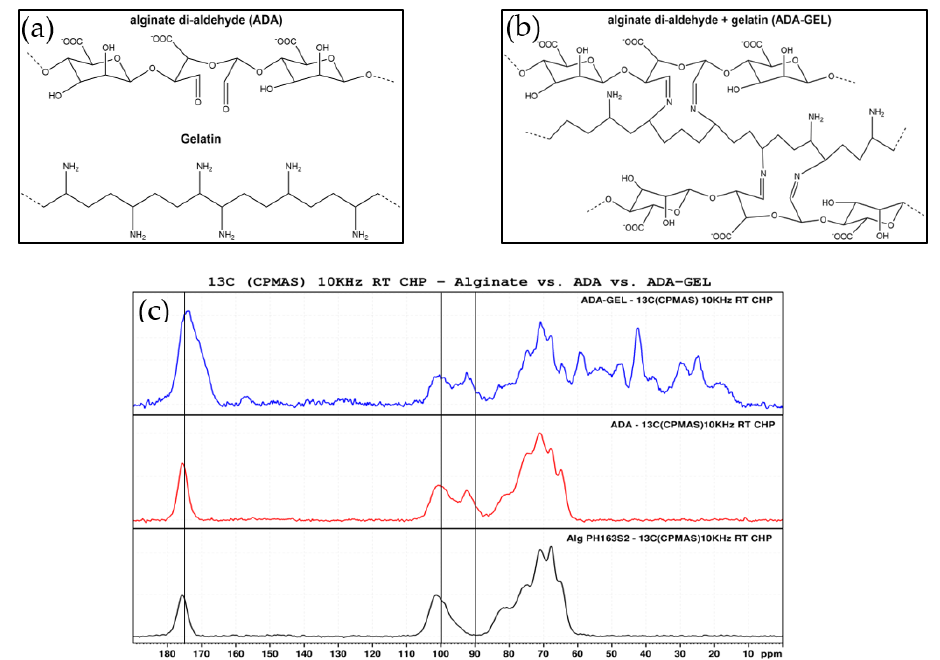
Figure 2. Schematic depiction of ( a ) ADA and gelatin separately and ( b ) ADA-GEL structure formed via Schiff base bond formation. ( c ) Solid state 13C NMR spectra of ADA-GEL, pristine ADA and alginate (from top to bottom).